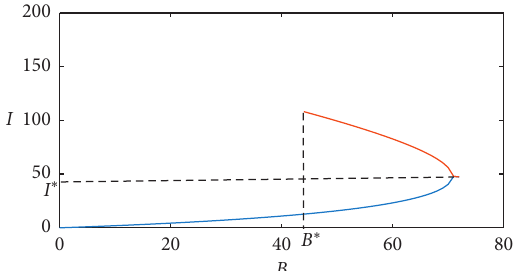
Figure 3: The relationship between the transport rate B and the infected animal populations I . B ∗ indicates that there are two